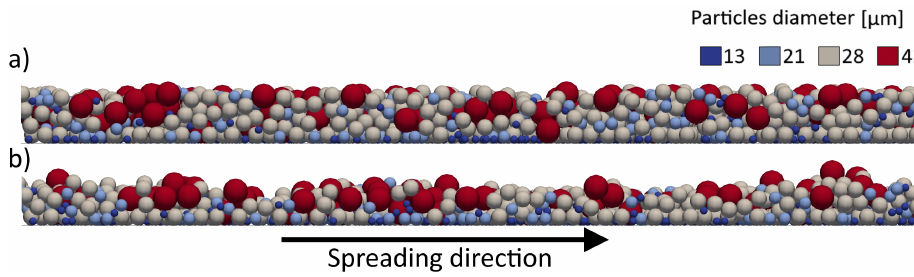
Figure 6. State of the powder reservoir after the spreading for two different speeds of the blade: ( a ) 20mm/s, ( b )